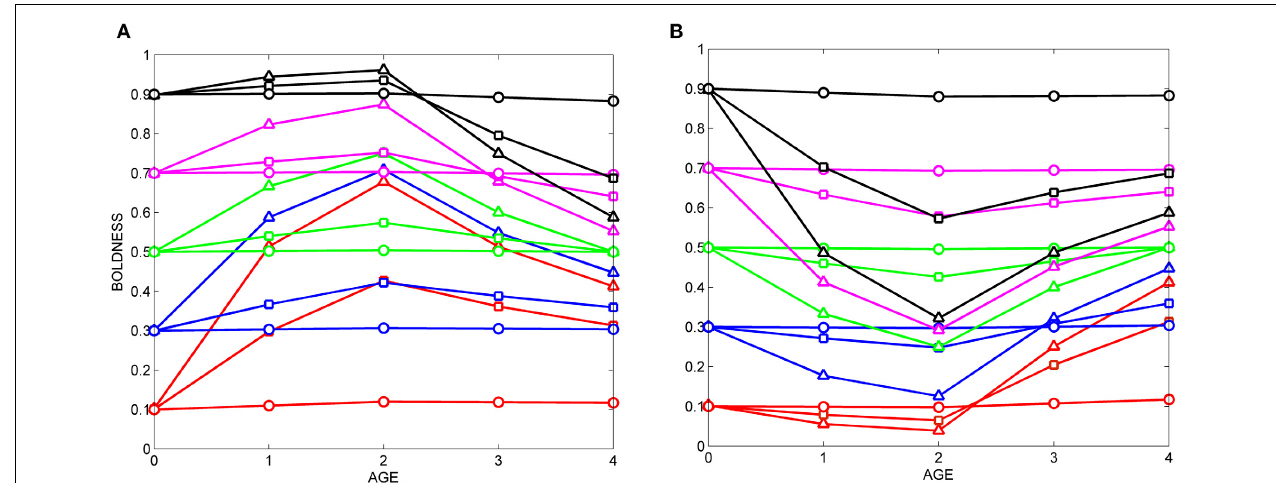
FIGURE 5 | Sequential exposure to cues with different likelihood functions. (A) Fifteen hypothetical individuals are first exposed from age 0 to age 2 to cues indicating that the world is relatively safe (see box in Figure 2 ), then are exposed from age 2 to age 4 to cues indicating that the world is relatively dangerous (see box in